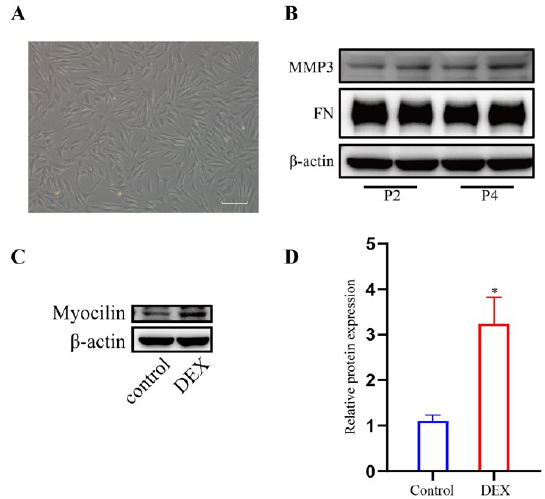
Figure 1. Characterization of HTM cells. ( A ) Phase-contrast microscopic images of HTM cells. ( B ) The band of MMP3 and FN in HTM cells at passage 2(P2) and passage 4(P4). ( C , D ) DEX treatment (1 μM for 72 h) increased myocilin expression in HTM cells, which was indicated by ( C ) the bands of myocilin and ( D ) quantification analysis of the myocilin expression level. * p < 0.05.